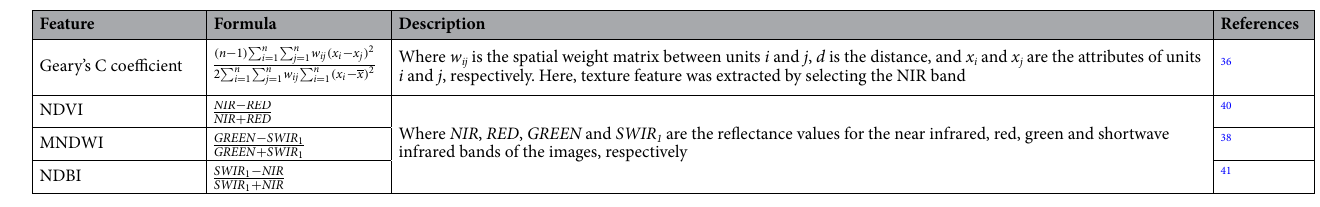
Table 2. The description of the selected